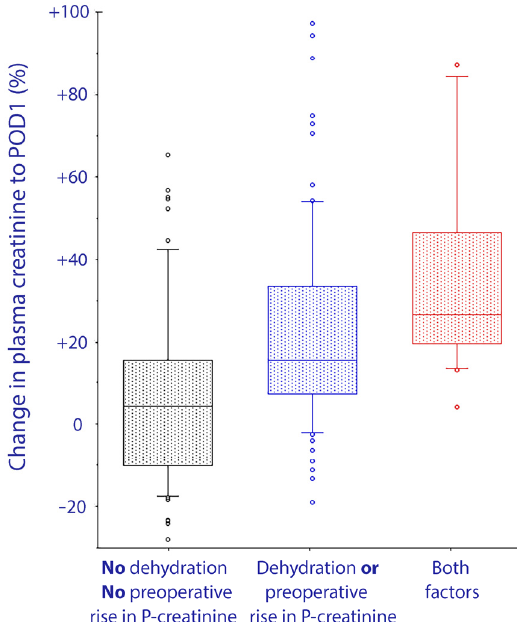
Figure 3. Change in plasma creatinine (as a percentage) from the day before surgery to the first day after surgery, depending on whether patients were dehydrated and/or showed an increase in plasma creatinine from the day before surgery to just before the surgery started. The box shows the 25th, 50th, and 75th percentiles and the error bars indicate the 10th and 90th percentiles. Exploratory analyses suggested that a body mass index > 30 kg/m 2 ( n = 43) served as an additional independent predictor that would strengthen the presented correlations.